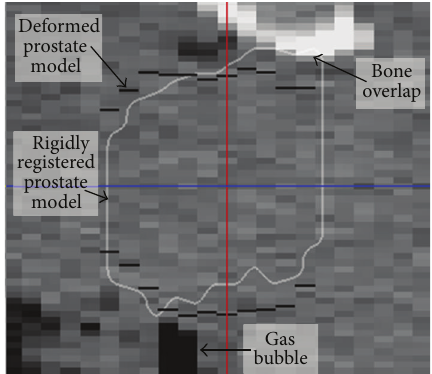
Figure 4: Midsagittal slice from a tCT illustrating how prostate rotation is treated as a deformation. The white outline is the atlas prostate after automatic registration to the tCT. The black dashes are the deformed atlas in the